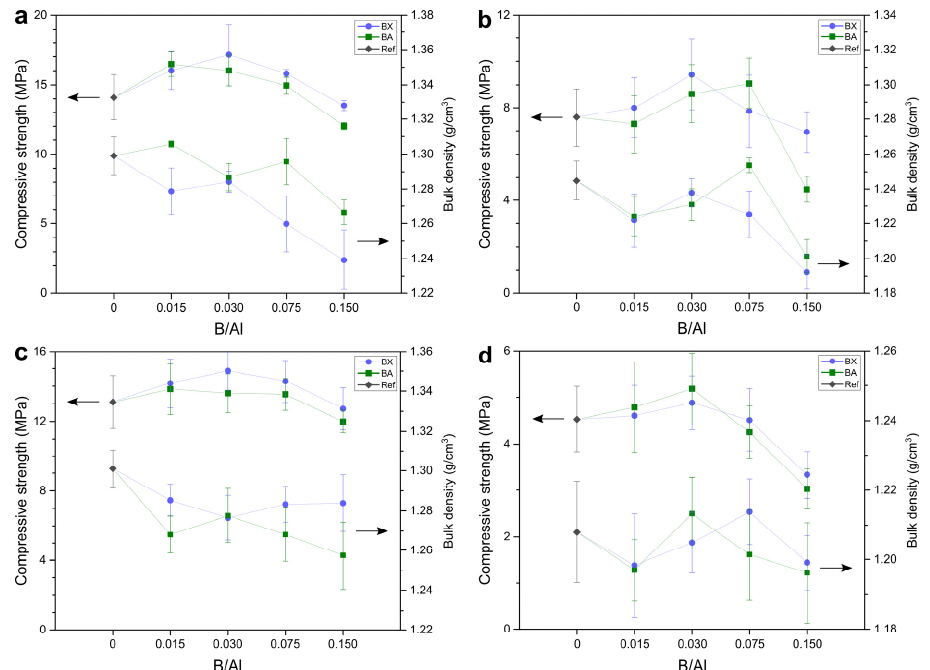
Figure 7. The compressive strength and bulk density of the geopolymers with borax (BX) and boric acid (BA) as the source of boron and ( a ) 2 wt.% of Pb 2+ , ( b ) 2 wt.% Ni 2+ , ( c ) 4 wt.% of Pb 2+ , and ( d ) 4 wt.% Ni 2+ (Ref—reference sample without boron). Materials 2021 , 14 , x FOR PEER REVIEW